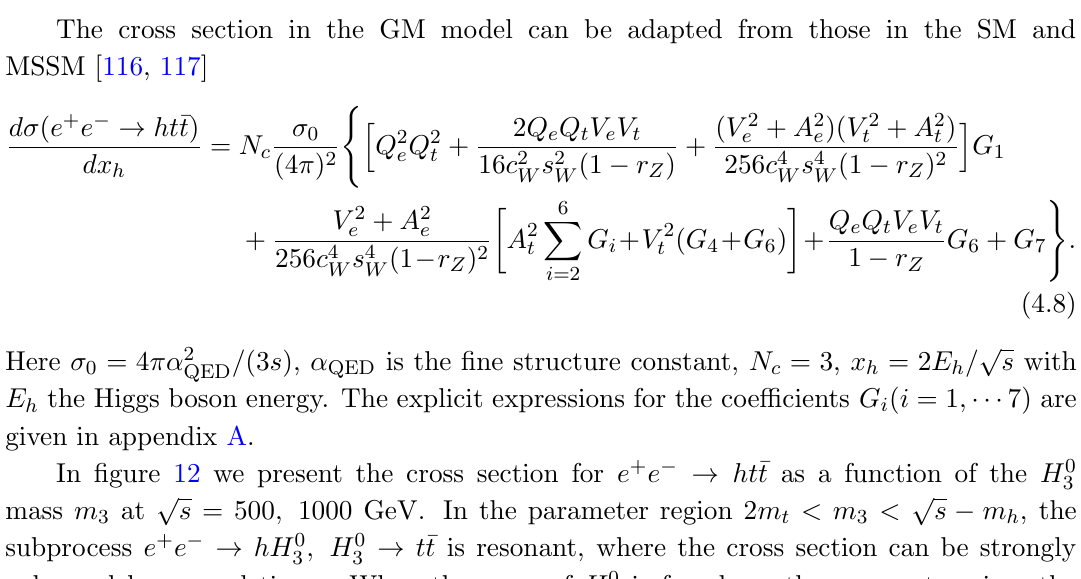
! ht (cid:22) t as a function of the H 0 (cid:0)